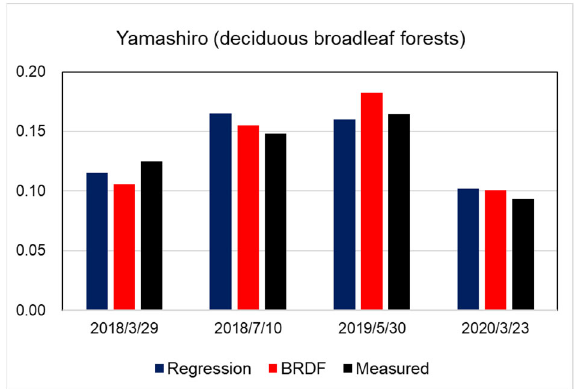
Figure 6. Temporal albedo of Yamashiro, Japan estimated from SGLI data. “Regression” denotes the results applying multi- regression models for vegetation class to SGLI surface reflectance, and “BRDF” denotes the results using the BRDF model parameters provided in SGLI surface reflectance products.